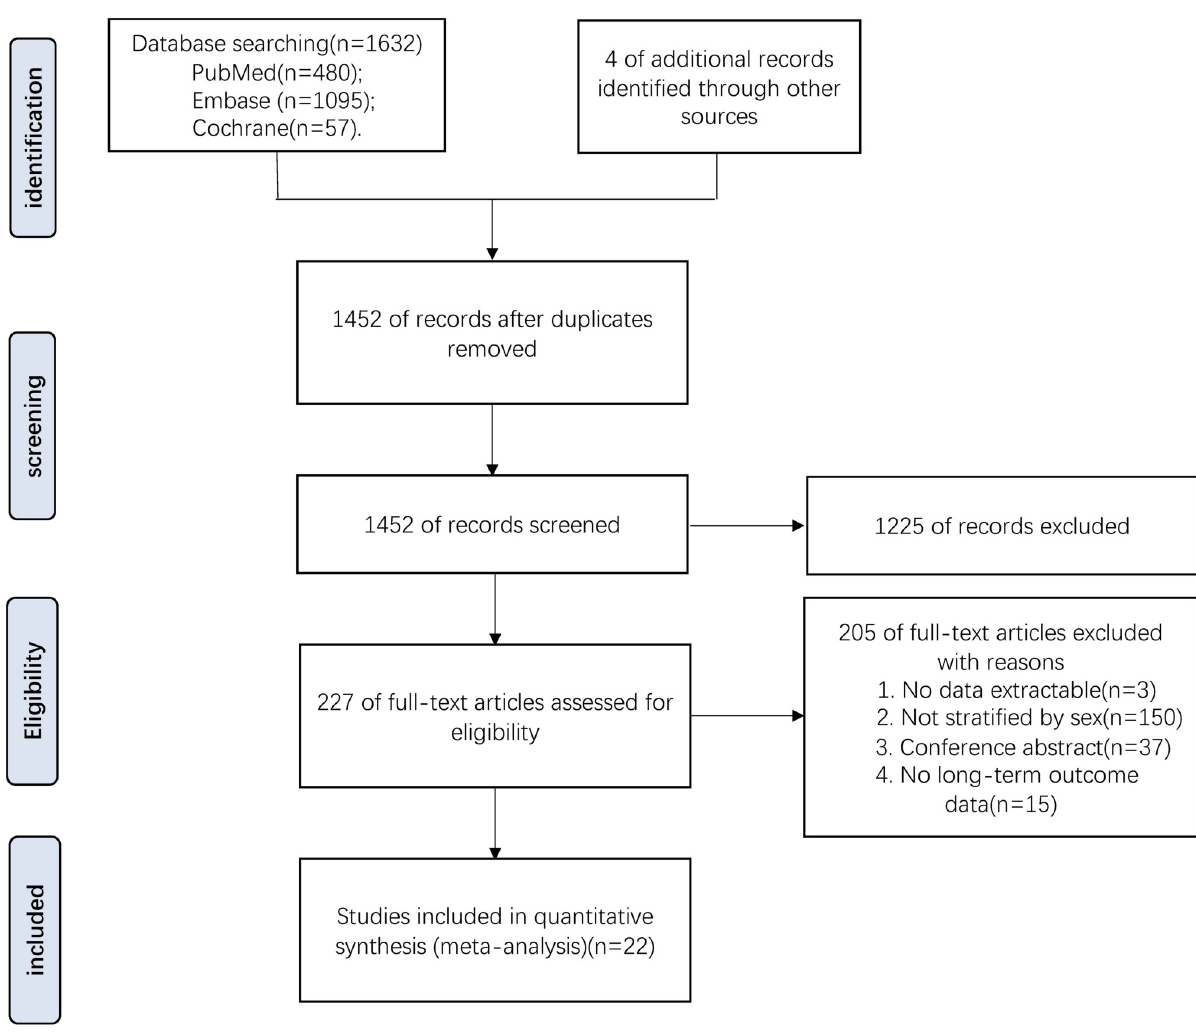
Fig 1. Flow chart showing the search strategy.